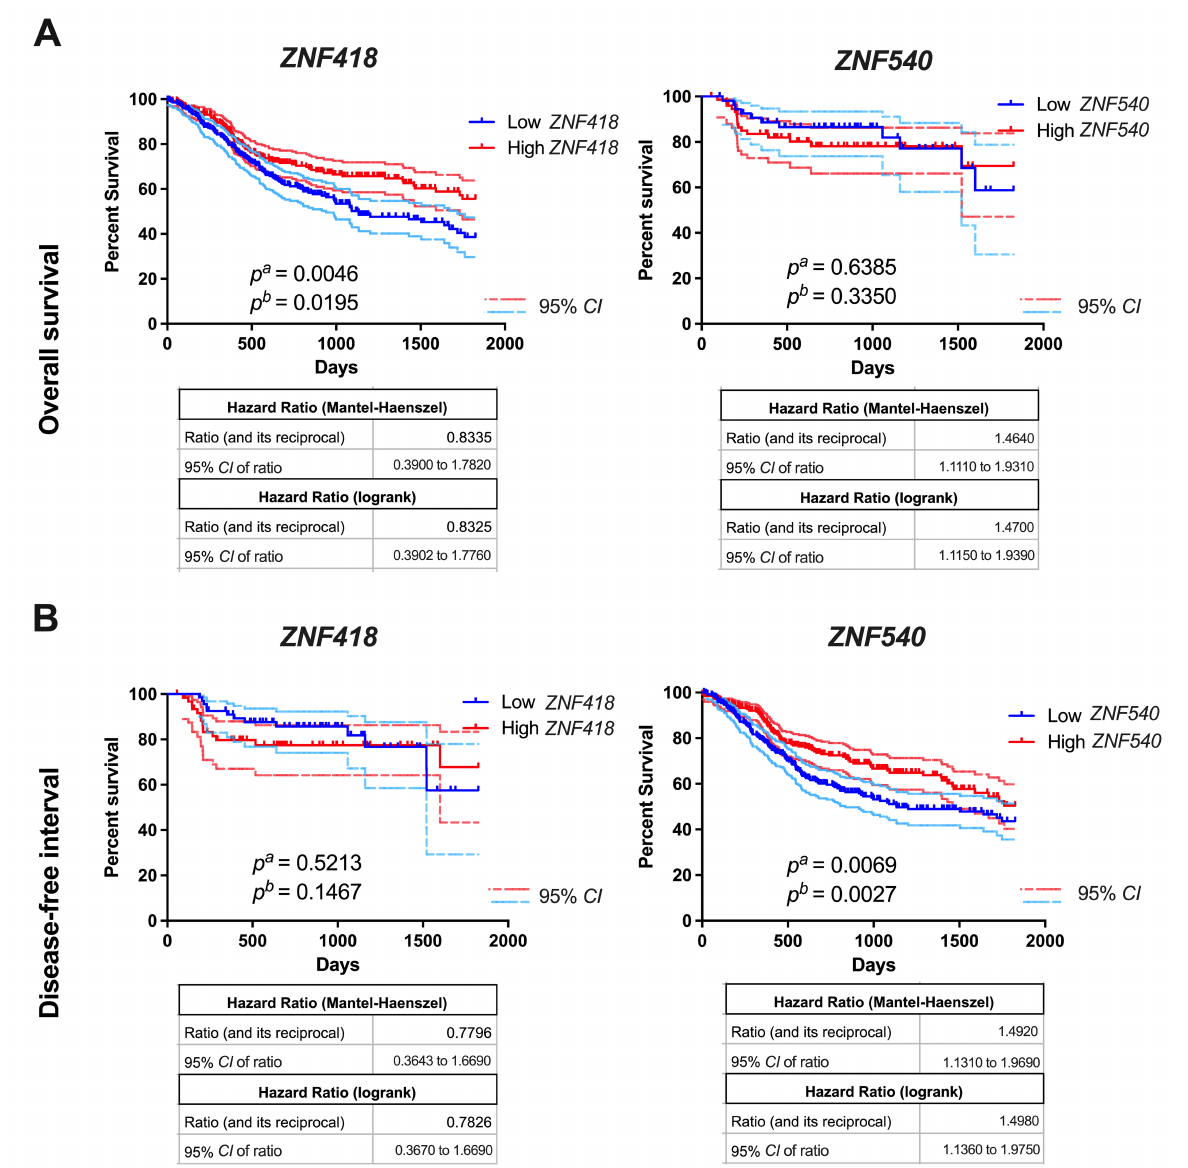
Figure 3. Overall survival (OS) ( A ) and disease-free interval (DFI) ( B ) of HNSCC patients depending on the ZNF418 (for OS: n Low = 271, n High = 250; for DFI: n Low = 68, n High = 62) and ZNF540 (for OS: n Low = 261, n High = 260; for DFI: n Low = 55, n High = 75) expression levels. The results are presented